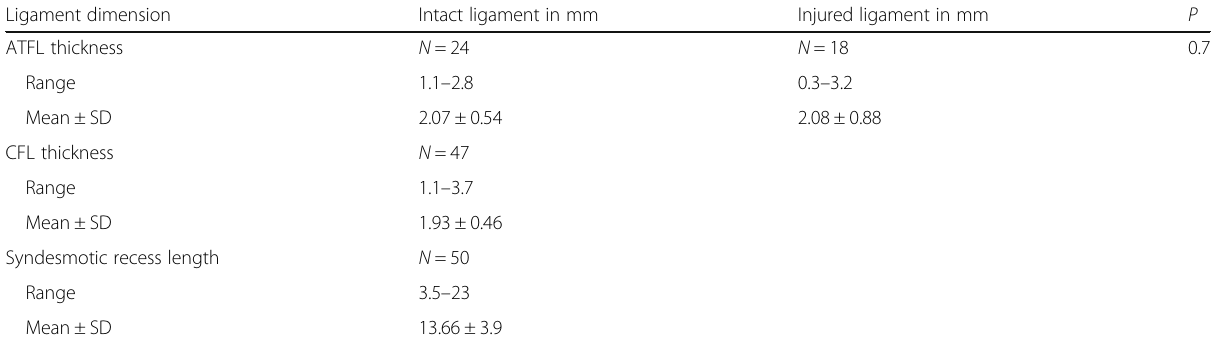
Table 2 Some ligamentous morphology on CT arthrography Ligament dimension Intact ligament in mm Injured ligament in